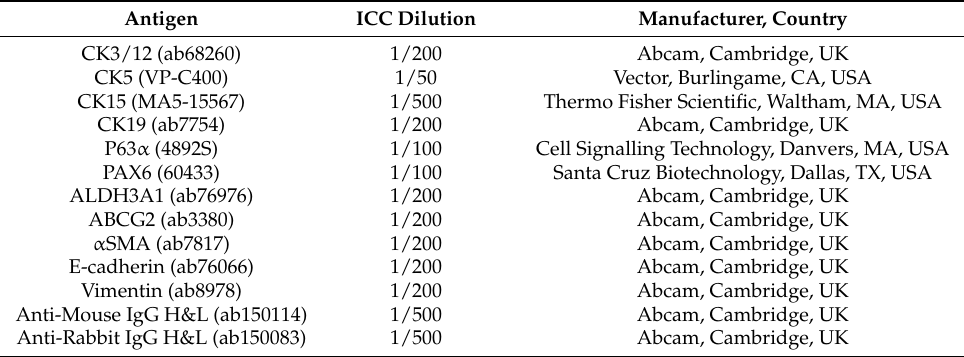
Table 2. Antibodies used in immunofluorescence